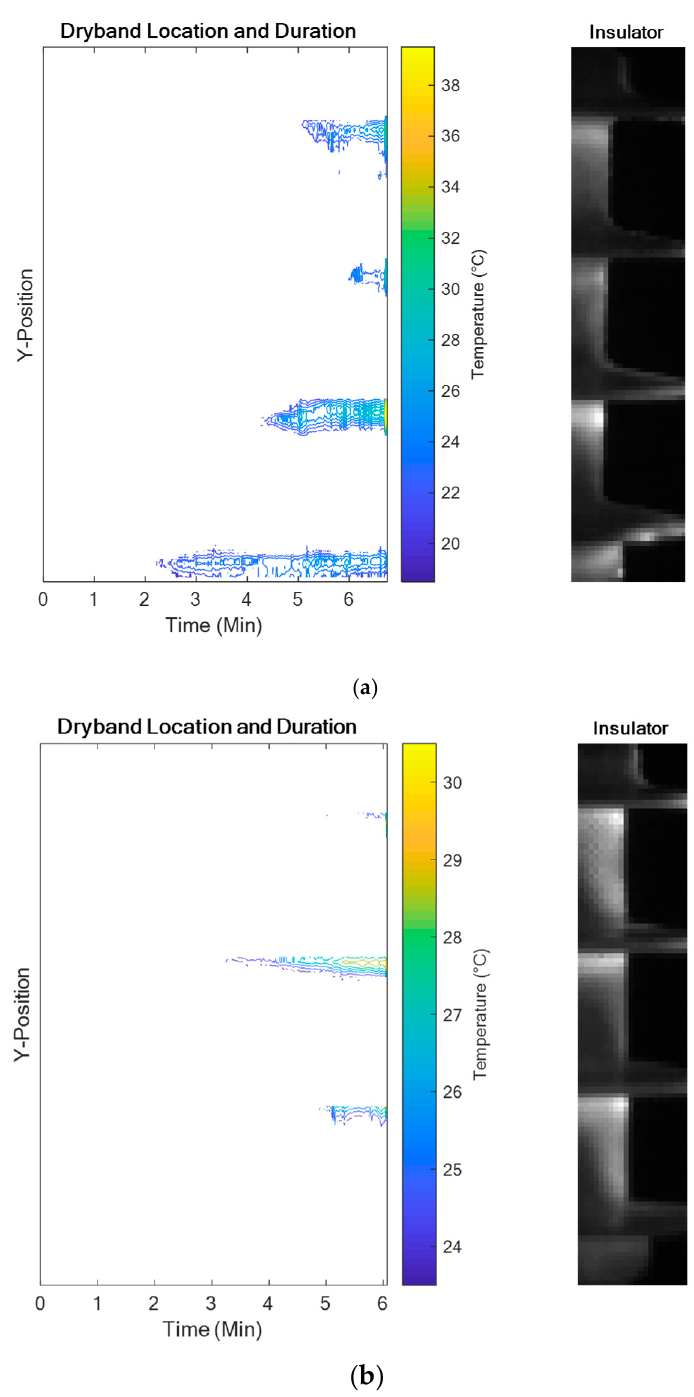
Figure 9. Dry-band extension as function of time and dry-band temperature range for the ( a ) conventional design and ( b ) textured TT4 insulator examples.